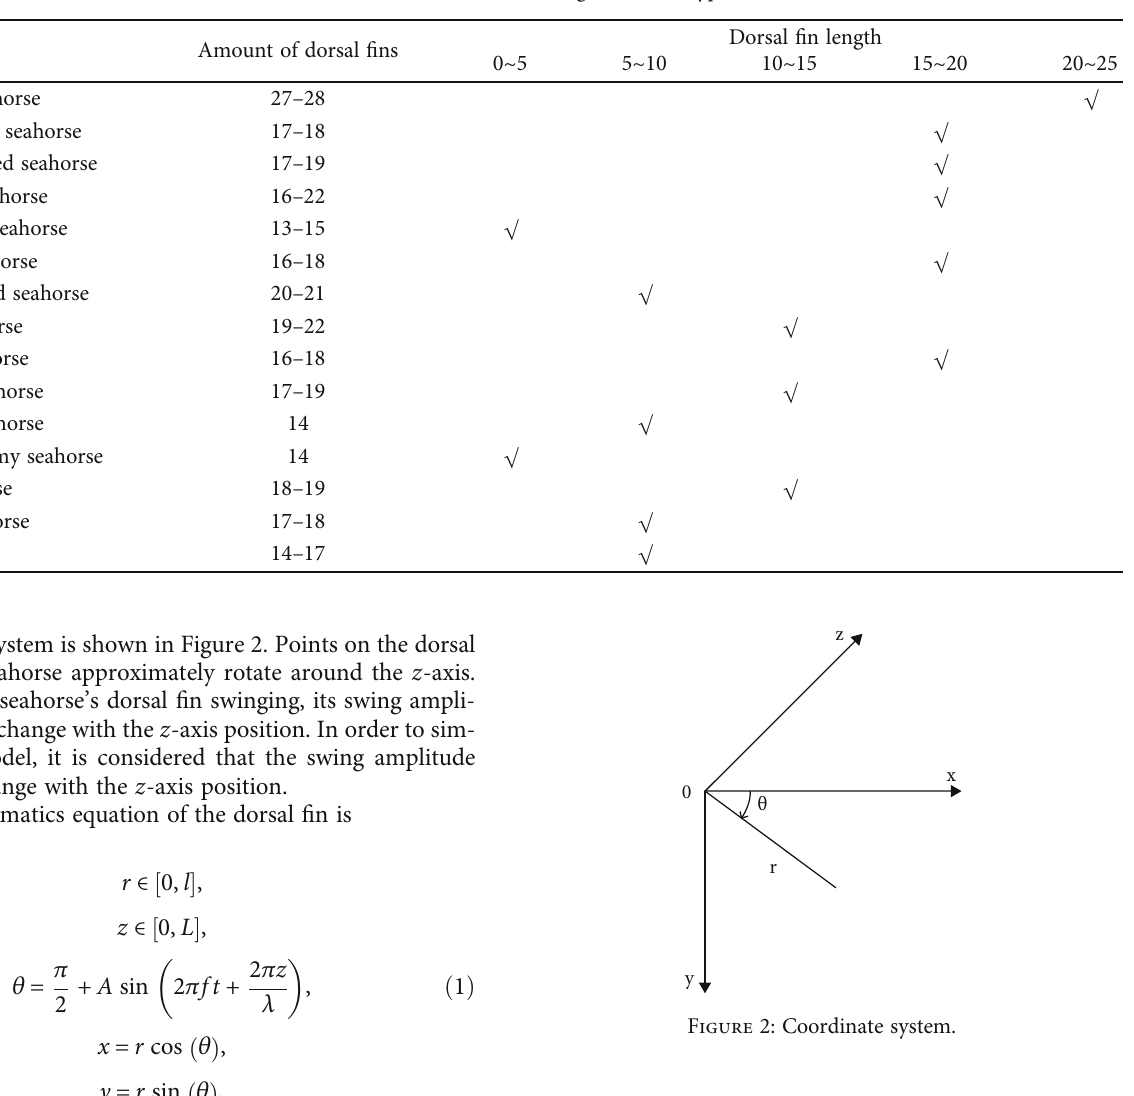
Table 1: The number of fi ns and dorsal fi n length of some types of seahorse.